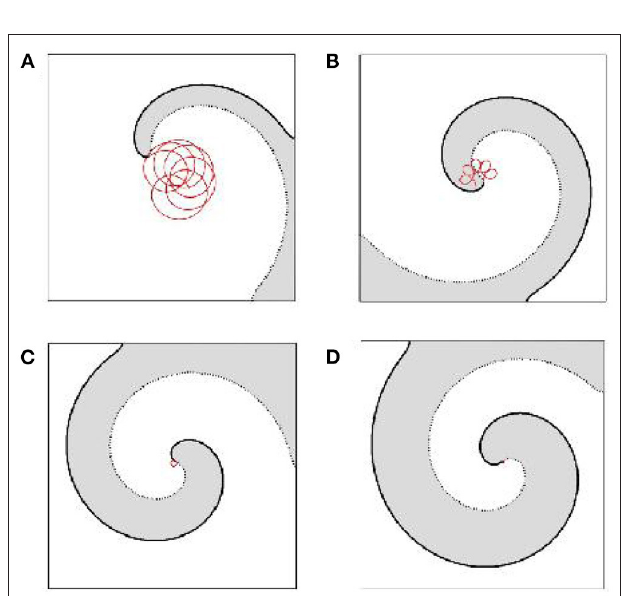
FIGURE 2 | Spiral waves dynamics obtained for the system (1)–(3) with ǫ = 0.01, k ǫ = 2 and b = 0.01 for different values of the parameter a . In (A) a = 0.22, in (B) a = 0.4, in (C) a = 0.6, and in (D) a = 0.8. Thick and dotted solids represent the wave front and back, correspondingly. The trajectory of the spiral wave tip is shown in